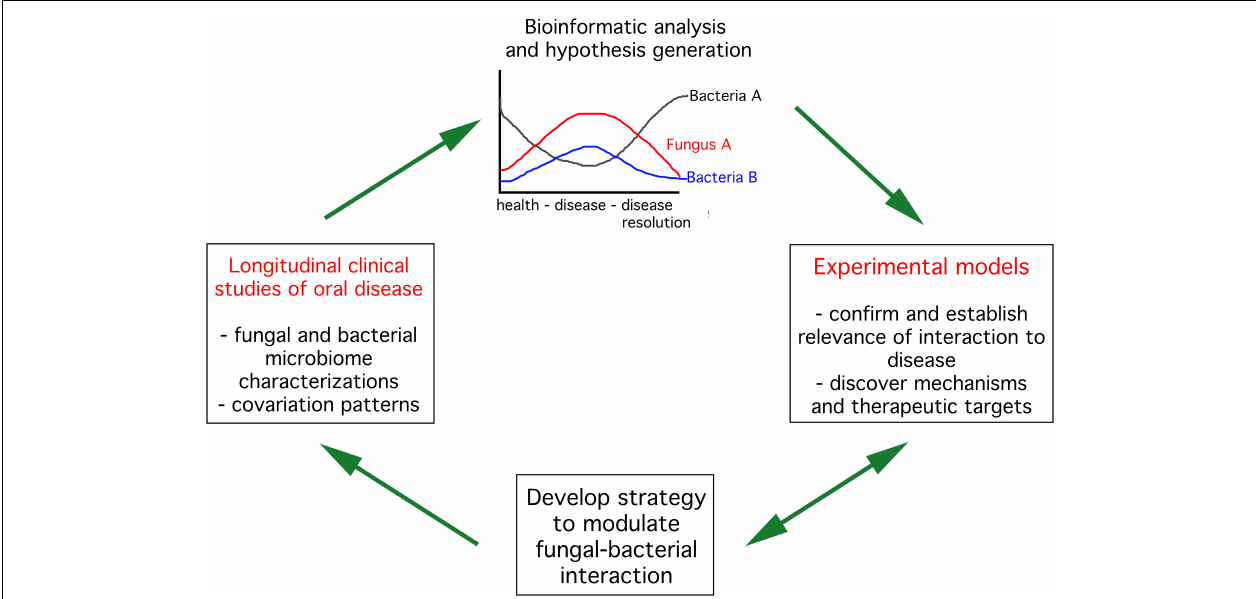
FIGURE 1 | Strategies to advance knowledge on fungal bacterial interactions in the context of oral health. The first step (left panel) is to conduct longitudinal clinical studies in humans characterizing the fungal and bacterialcomponentsofthemicrobiomethroughoutprogressionandresolution of oral diseases. These observational studies should lead to identification of potential positive (top panel, fungus A and bacteria B) or negative (top panel,